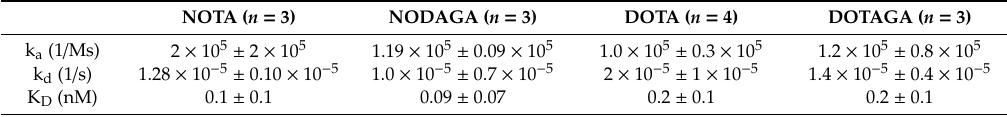
Table 2. A ffi nity measurements. Association rate (k a ), dissociation constant (k d ) and equilibrium dissociation constant (K D ) measured on living BxPC-3 cells in real time using Ligand Tracer. NOTA ( n =